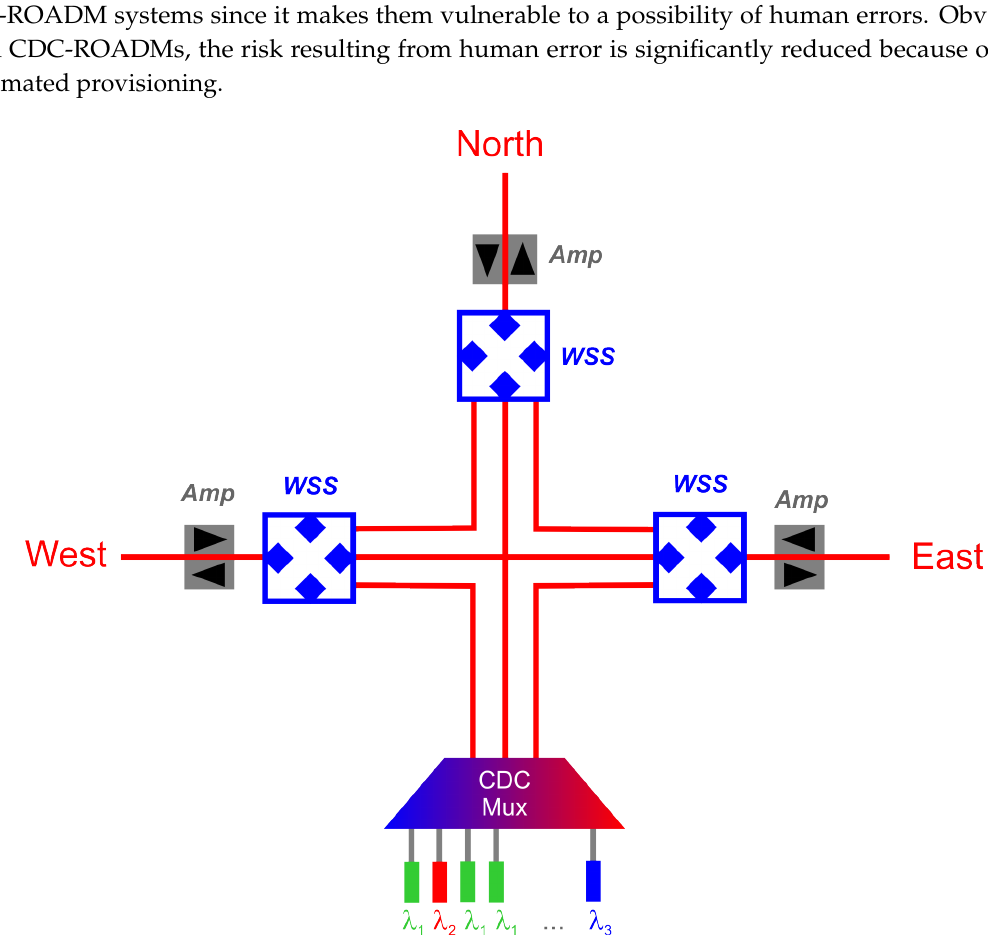
Figure 2. Schematic diagram of conventional CDC-ROADM. In this particular 3-degree CDC-ROADM architecture it is possible to add/drop 3 wavelengths λ 1 (green color) at the same mux/demux module, scheduled for 3 different directions: West, North and